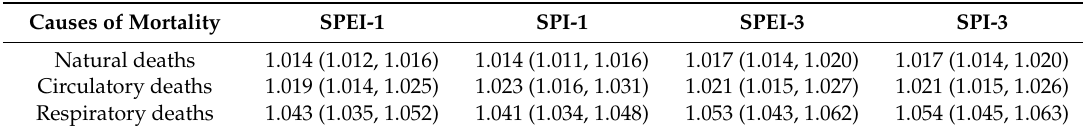
Table 1. Overall relative risks (RRs) and their respective 95% confidence intervals of daily specific-cause mortality associated with drought in peninsular Spain at national level from 2000 to 2009. Standardized Precipitation Evapotranspiration Index (SPEI) and the Standardized Precipitation Index (SPI) measured at one and three months of accumulation (SPEI-1 / SPI-1 and SPEI-3 / SPI-3,